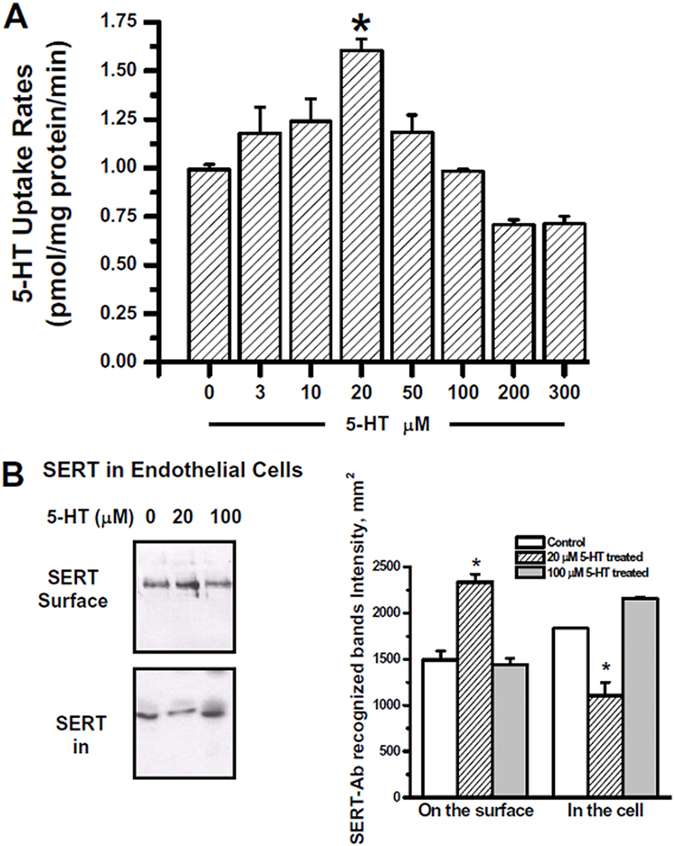
Endothelial cells pretreated with 5-HT.(A) Effect of 5-HT pretreatment on the 5-HT uptake ability of the endothelial cells. Endothelial cells in one well of a 24-well plate (2 × 105) were pretreated with (0–300 μM) 5-HT for 45 min at room temperature before uptake rates of [3H]-5HT were measured in intact cells Rate measured over three independent experiments, (p < 0.001). (B) Effect of 5-HT pretreatment on the surface expression of SERT. Endothelial cells were pretreated with 0, 20, or 100 μM 5-HT and biotinylated with NHS-SS-biotin162022. Biotinylated plasma membrane proteins were retrieved on streptavidin beads and analyzed for SERT by WB analysis. Intracellular SERT was determined by WB analysis of non-bound material. Cells without 5-HT pretreatment served as a control. Data are representative of at least three independent experiments. Actin served as a loading control. The results of WB analysis are the summaries of combined data from three densitometric scans (mean ± SD). *represents differences from 0 μM 5HT-matched samples (P < 0.001).